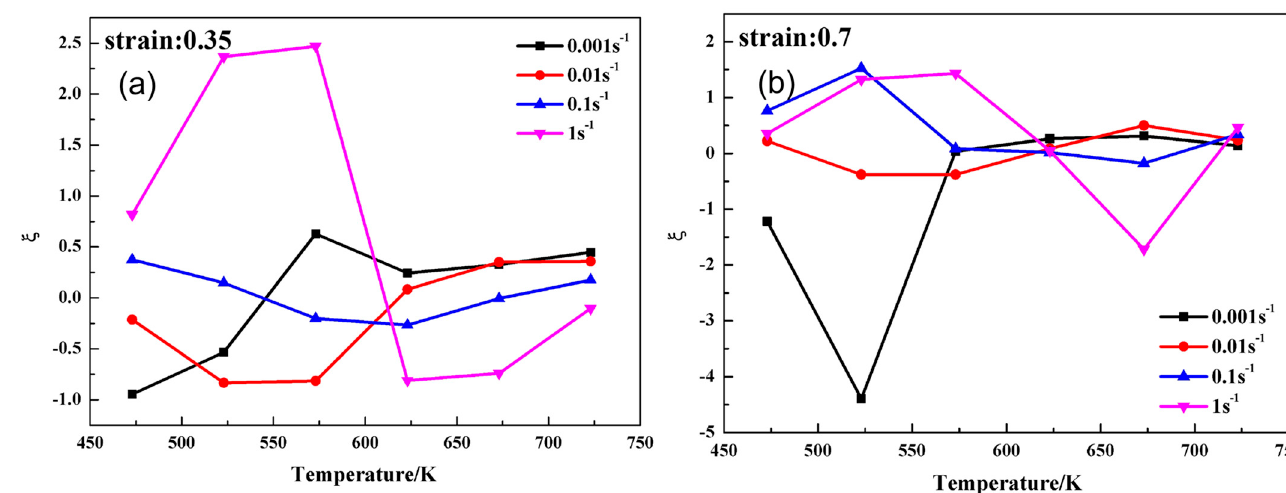
Figure 7. Relationship between the instability parameter ( ξ ) and the deformation temperature under di ff erent strains: ( a ) 0.35; ( b ) 0.7. different strains: ( a ) 0.35; ( b ) 0.7.